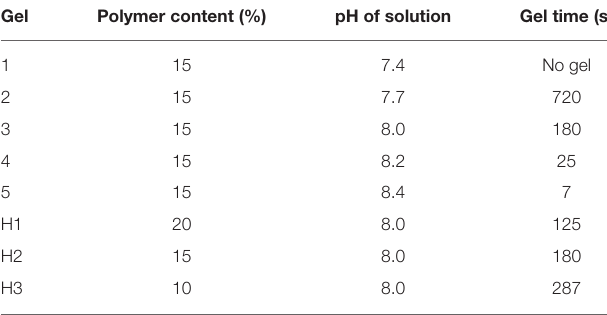
TABLE 2 | Gel time under different pH by inverted vial and visual